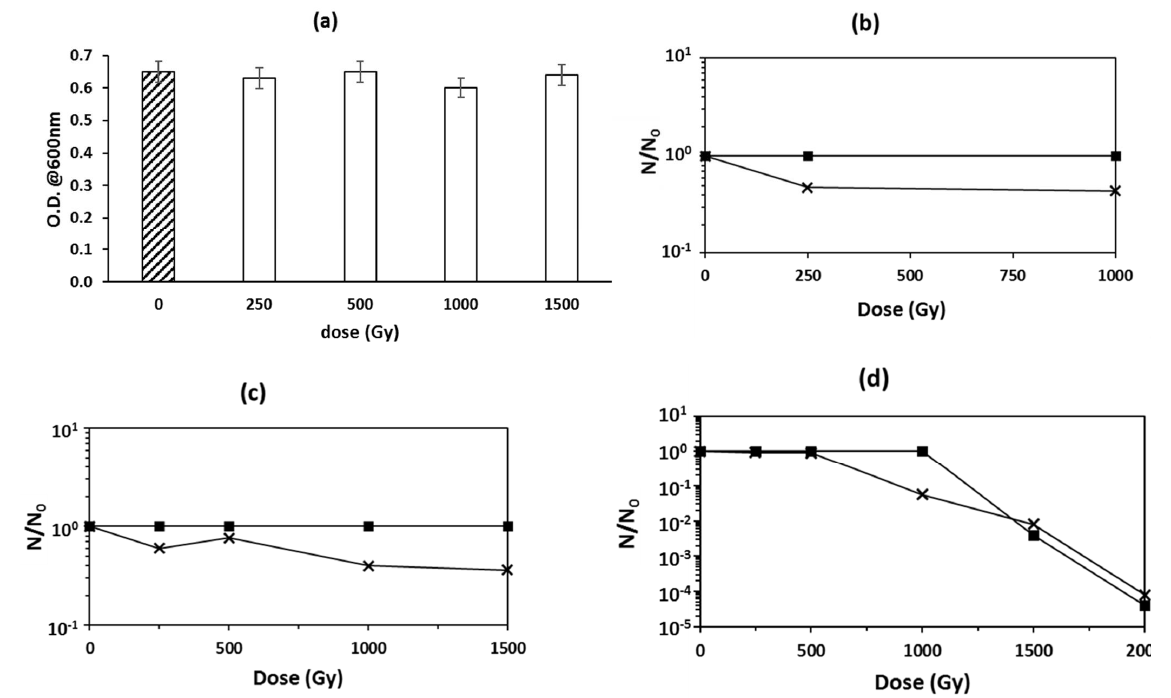
Figure 2. P. thermantarcticus’ spore survival after HZE irradiation. ( a ) Dried spores irradiated with Fe ions (legend: O.D.: optical density at 660 nm); ( b – d ) spores irradiated in isotonic solution with He ions, Ar ions, and Fe ions, respectively. (legend: (cid:4) spores surviving fraction measured 1 month after irradiation; × spores surviving fractions measured 1 year after irradiation).